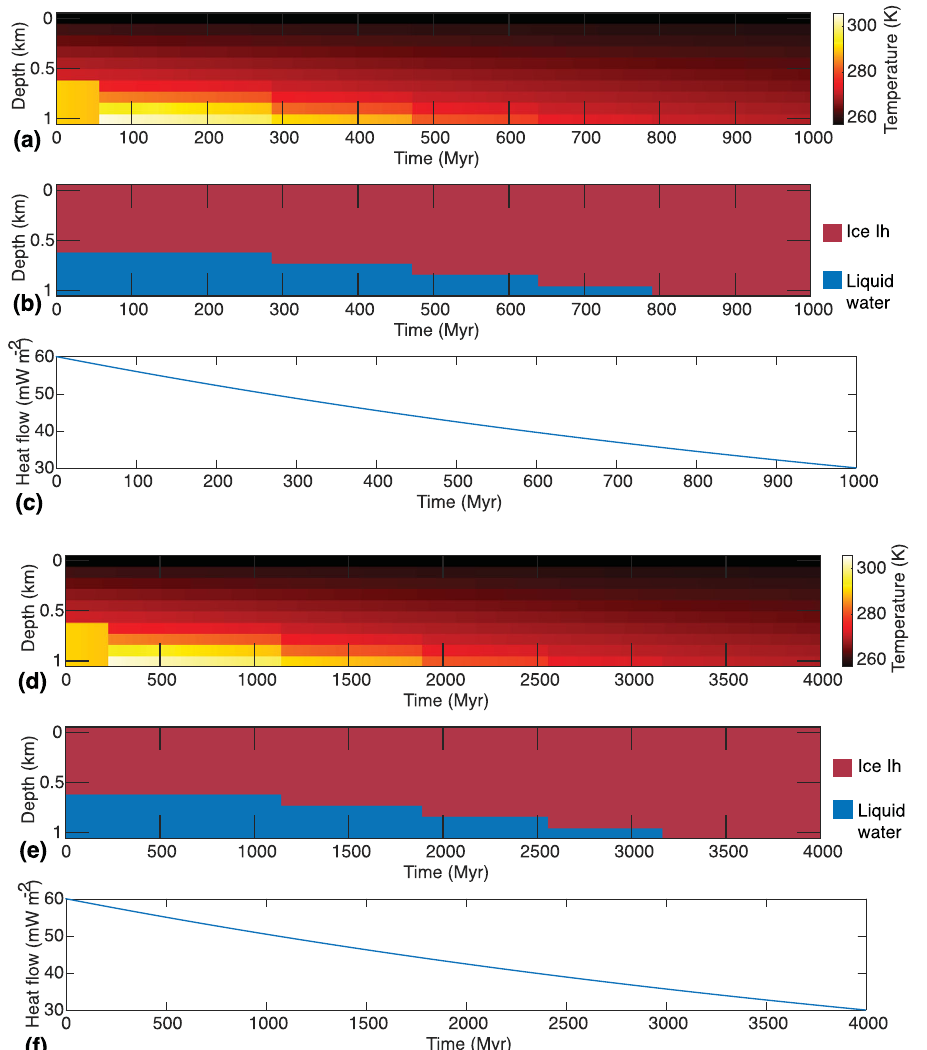
Fig. 8 | Temperature and ice phases as a function of depth within a 1-km thick ice sheet on Proxima Centauri B, assuming exponentially declining heat fl ow. a Temperaturedistributionasa function of depthand time on Proxima CentauriB for a 1km thick ice sheet assuming T s of 257K and variable heat fl ow over a billion years. b Icephase evolutionasafunctionofdepthand time onProximaCentauriB over a billion years. c An ad hoc exponential function that models heat loss on